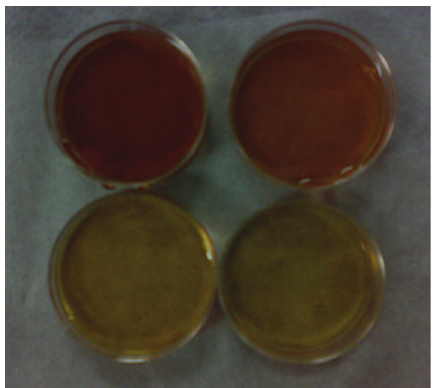
Figure 1: Color variation of honey samples from dark amber (top- left dish) to whitish yellow (bottom-right dish). Flavor of the honey depends upon the color, generally the darker the honey the stronger the flavor and quality.